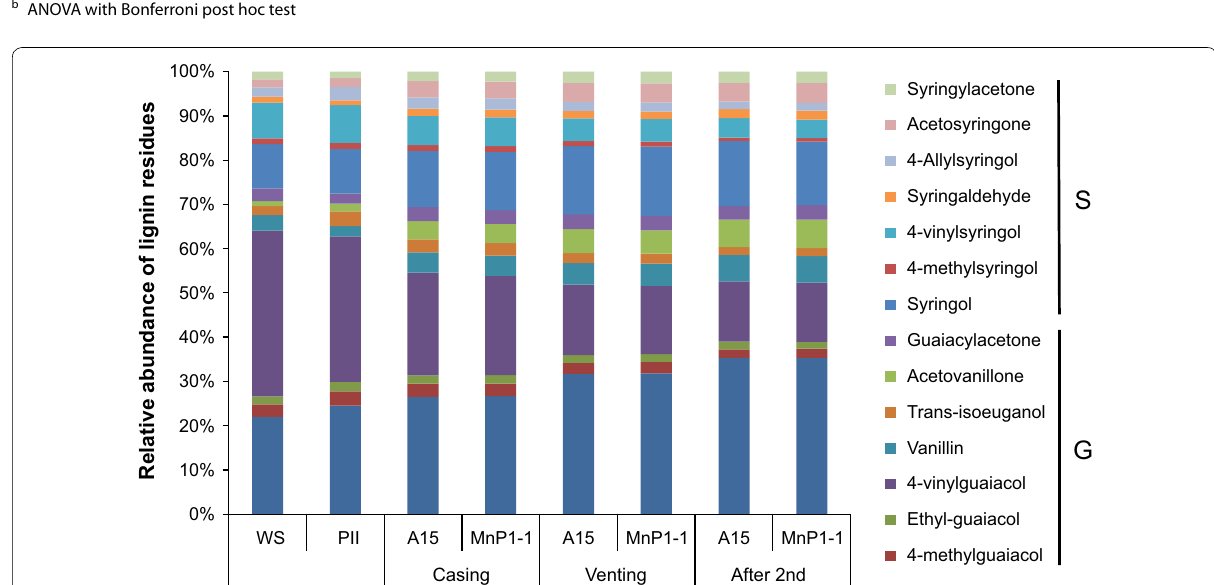
Each value represents the average of four biological replicas except for PII-end which represents three replicas and standard deviations are shown in brackets. Means of each ratio that share a letter (A, B or C) are not significantly different (ANOVA after log transformation). Differences between A15 and MnP1-1 are indicated with an asterisk (*) (T-test, Bonferroni correction, p < 0.01) a